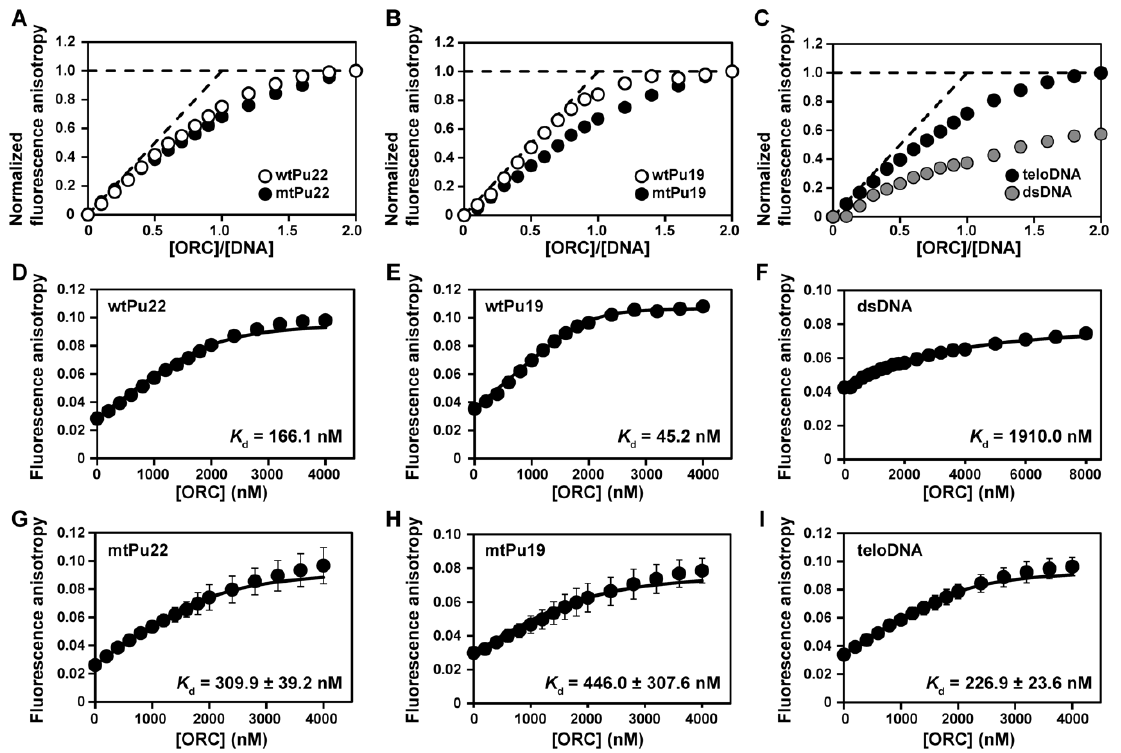
Figure 1. Fluorescence anisotropy (FA) titration curves of FAM-labeled G-rich DNAs derived from c-myc promoter or telomere regions against human origin recognition complex containing residues 413–511 (hORC1 413–511 ). Changes in the normalized FA of FAM-labeled wtPu22 (open) and mtPu22 (solid) ( A ), those of FAM-labeled wtPu19 (open) and mtPu19 (solid) ( B ), and those of FAM-labeled dsDNA (grey) and teloDNA (black) ( C ) upon titration. Titration curves were fitted by using Equations (1) and (2) for FAM-labeled wtPu22 ( A , D ), for FAM-labeled wtPu19 ( B , E ), for FAM-labeled dsDNA ( C , F ), for FAM-labeled mtPu22 ( A , G ), for FAM-labeled mtPu19 ( B , H ), and for FAM-labeled teloDNA ( C , I ). The experiments in panels G, H, and I were performed in triplicate and the standard deviation is indicated for each point.